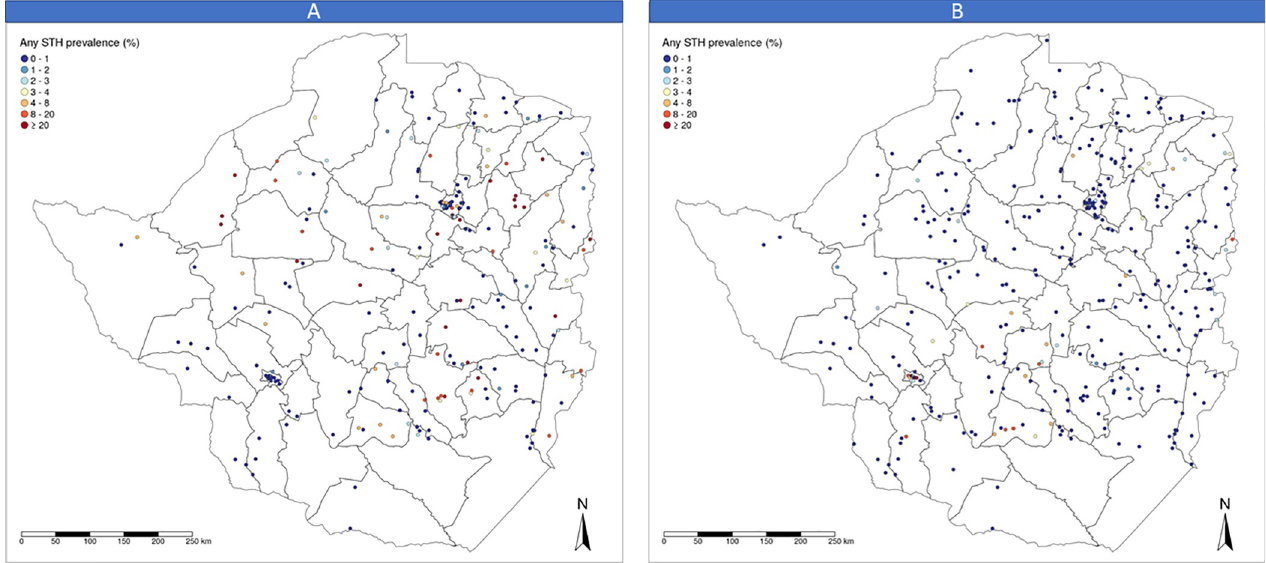
Fig 1. Maps presenting the location and STH prevalence in schools surveyed at baseline (A) 225 schools and at impact assessment survey (B) 336